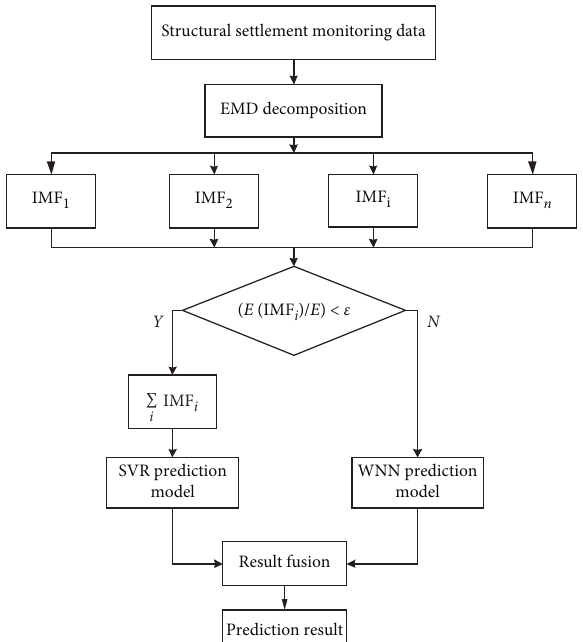
Figure 2: EMD-SVR-WNN prediction model